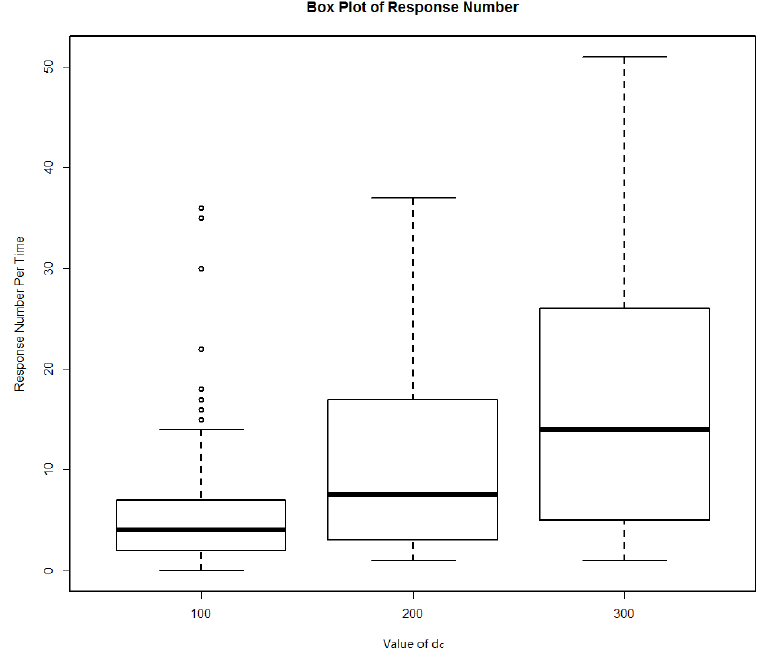
Figure 10. The number of response users. Table 2. The number of response user.